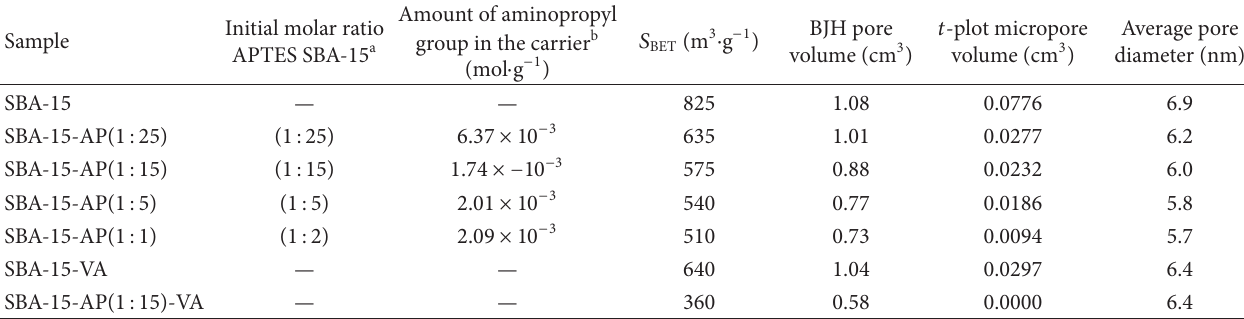
T 1: Characterization of modi�ed SBA-15 with aminopropyl groups and the carriers loaded with valproic